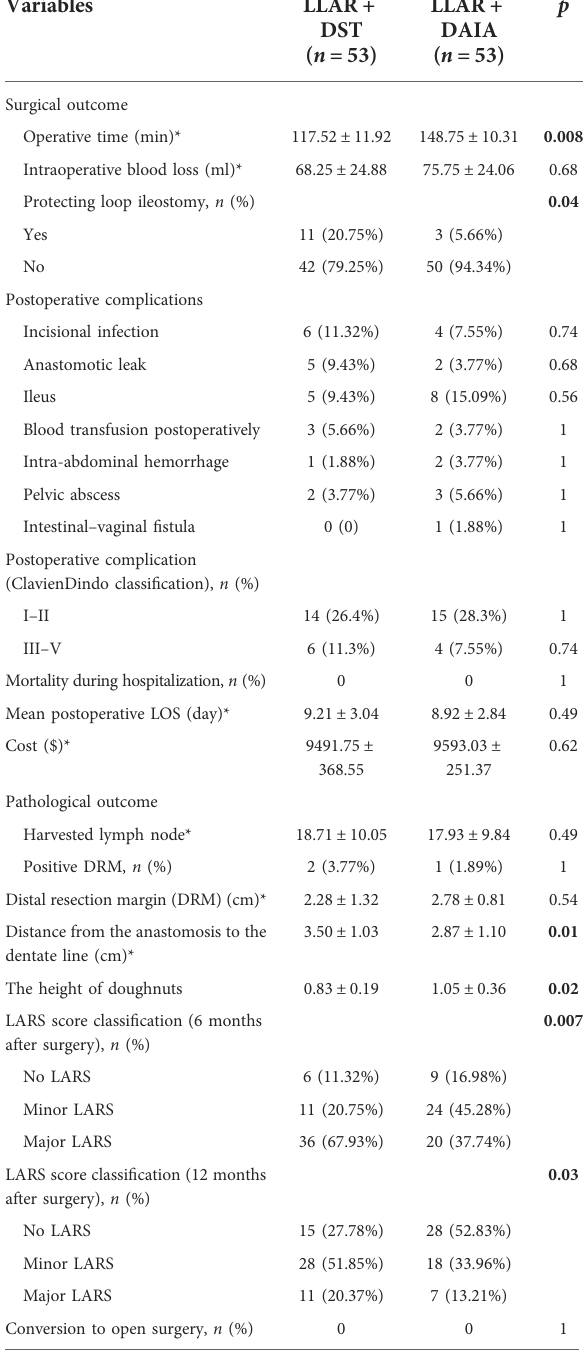
TABLE 2 Perioperative outcomes and pathologic outcomes in patients with rectal cancer operated on by LLAR+DST or LLAR+DEIA after propensity score matching ( n